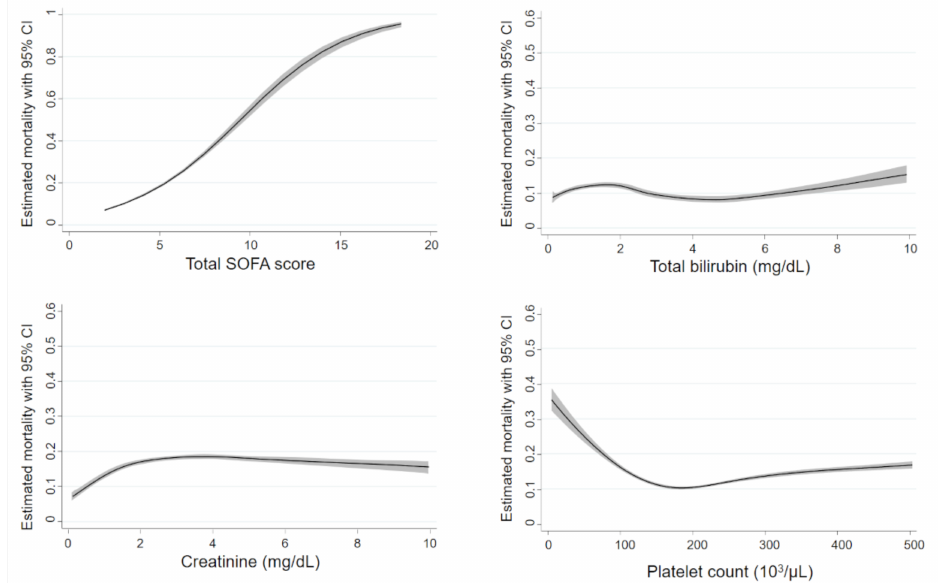
Figure 2. Non-linear association between mortality and the components of the SOFA. The black line represents the fitted line of the association between biomarkers and the estimated mortality risk, and the shaded region represents the 95% confidence interval. Total SOFA score was the sum of the five SOFA subscores except for the respiratory subscore. SOFA: Sequential Organ Failure Assessment, CI: Confidence